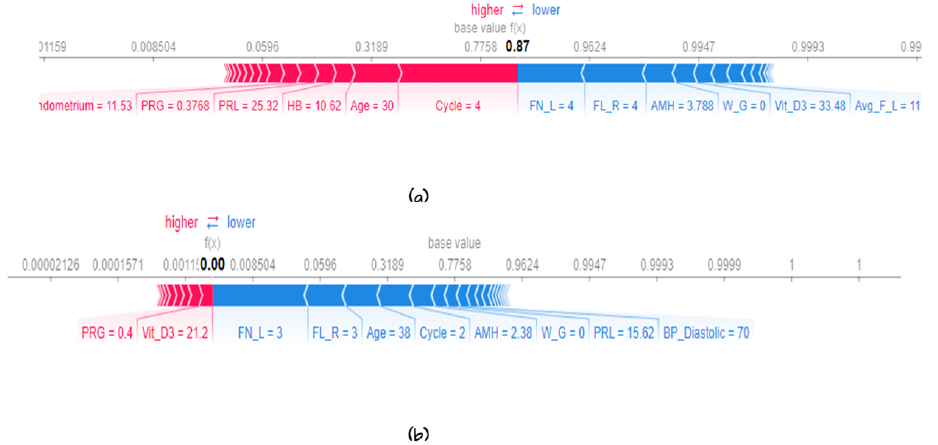
Figure 13. Individual fore plot for several instances according to the developed model ( a ) for observation 1 and ( b ) for observation 2.